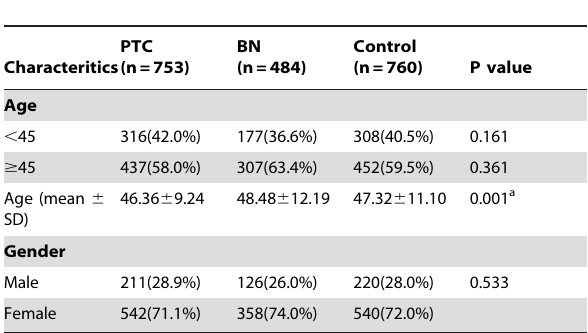
Table 1. The age and gender distribution of papillary thyroid cancer (PTC), benign thyroid tumor (BN) and control study